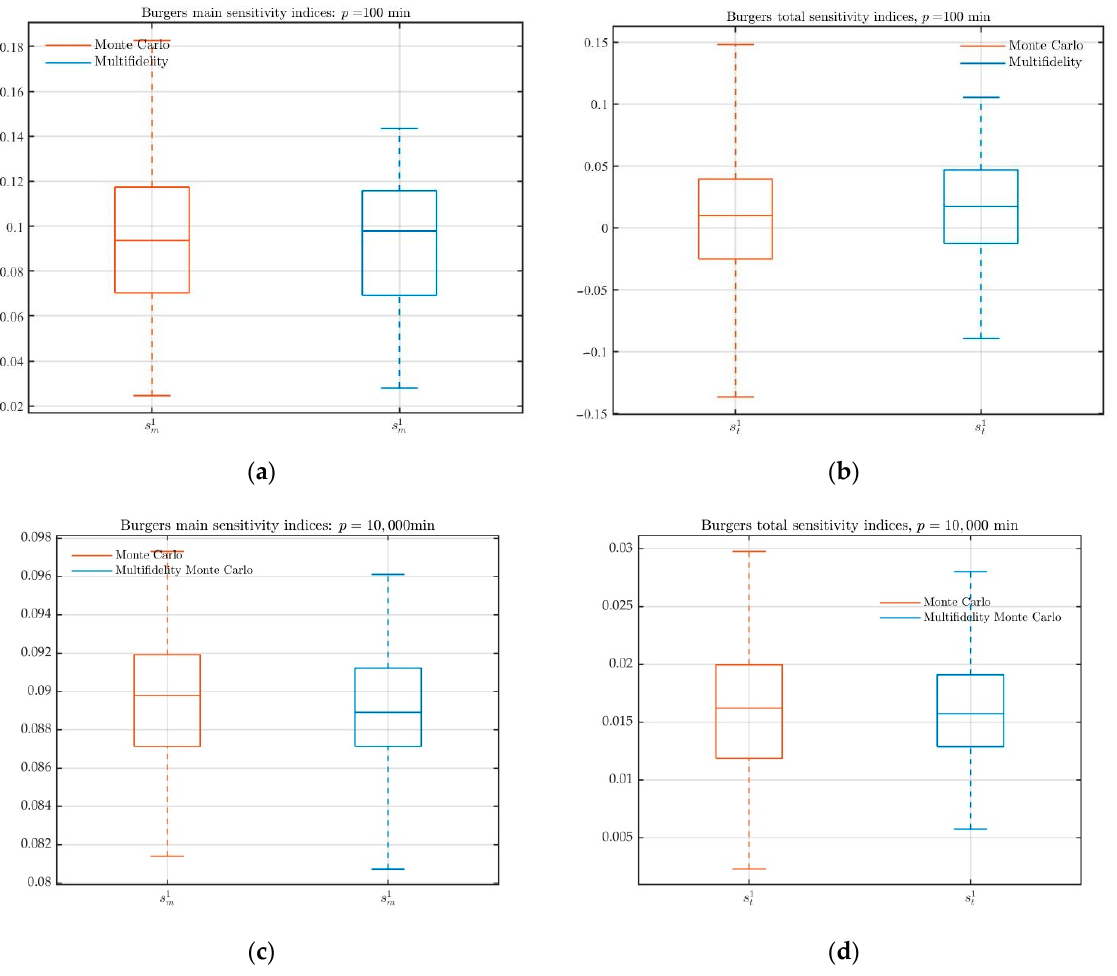
Figure 7. ( a , b ) Comparison of the MFMC and standard MC estimates of main or total effect sensitivities for the Burgers’ Equation (24) with computational budgets p = 100. ( c , d ) Comparison of the MFMC and standard MC estimates of main or total effect sensitivities for the Burgers’ Equation (24) with computational budgets 10,000 p = .